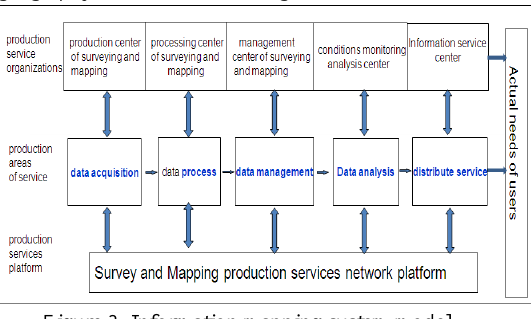
Figure 3. Information mapping system